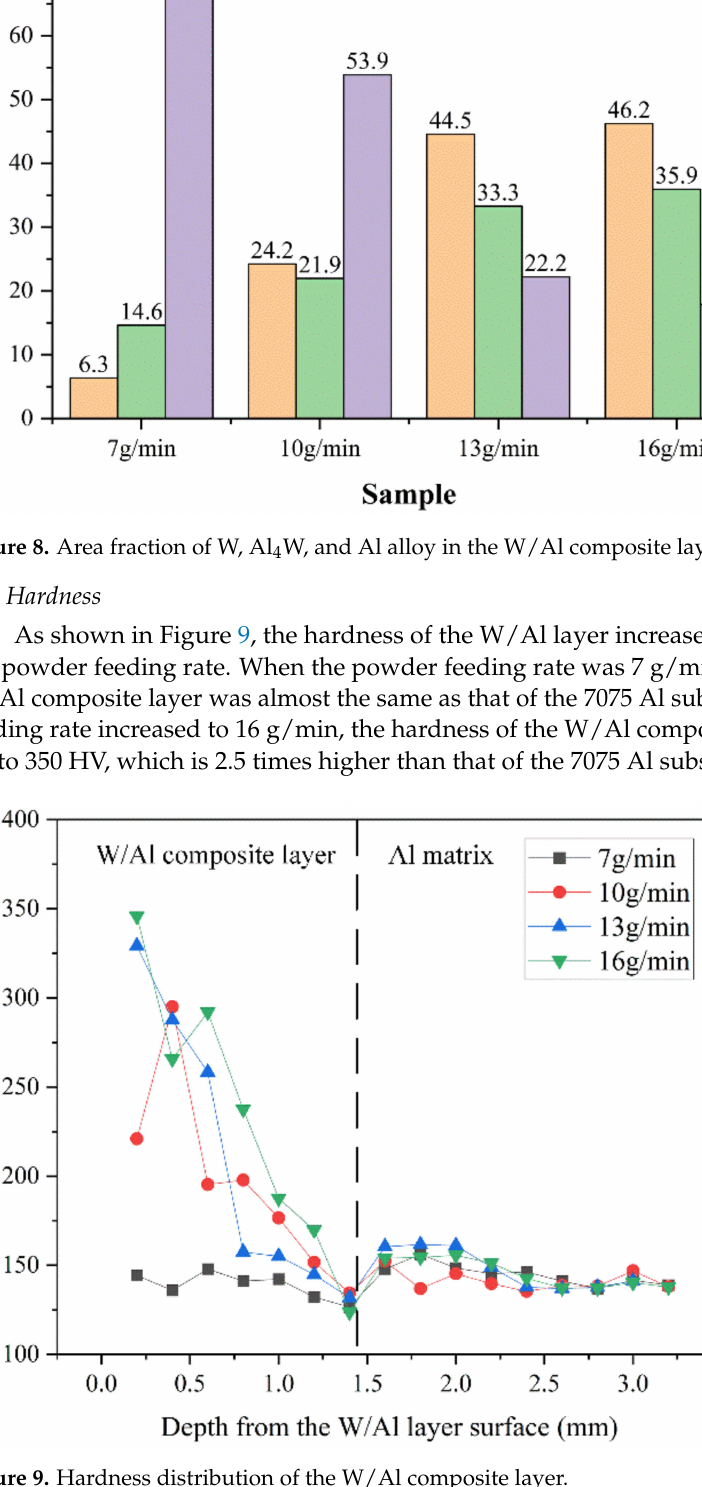
Figure 9. Hardness distribution of the W/Al composite